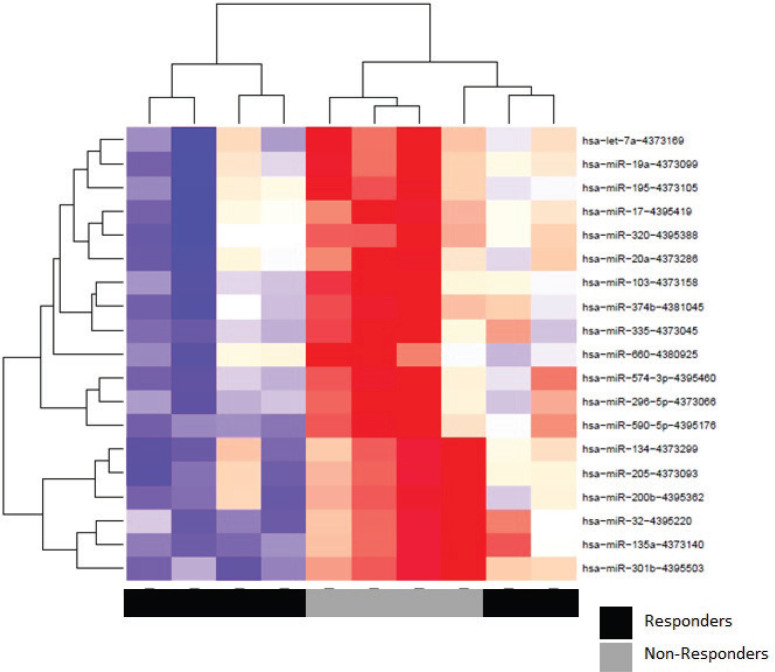
Heat map of hierarchical clustering analysis of miR expression (Pearson correlation) of responders and non-responders.